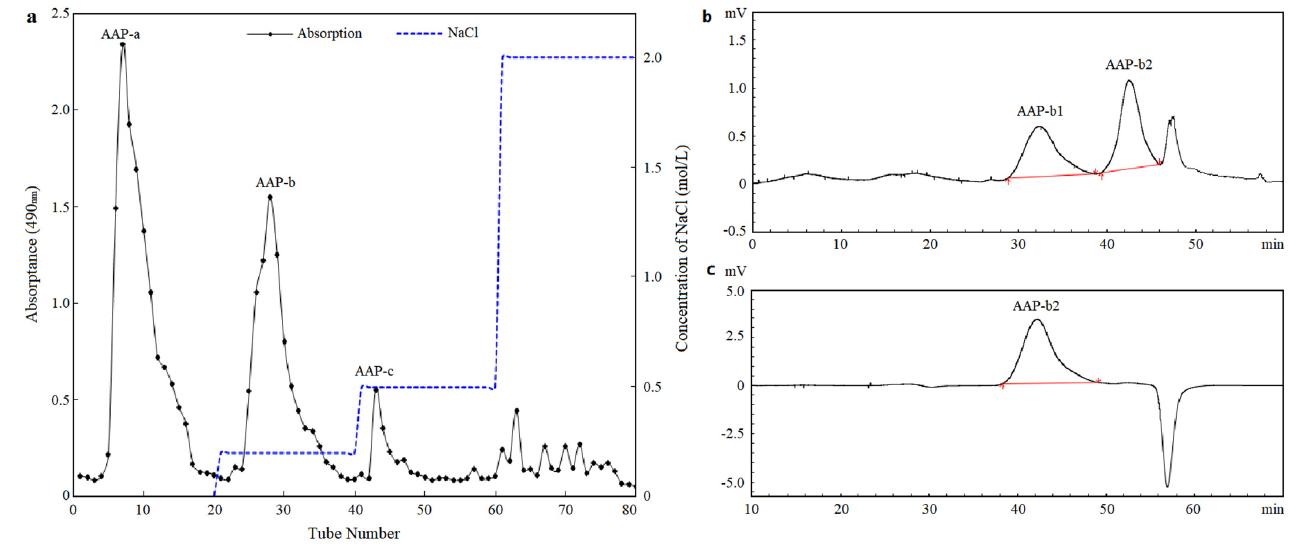
Figure 1. Isolation and purification of polysaccharides extracted from A. auricula . ( a ) Elution curve of AAP on DEAE Sepharose Fast Flow column. ( b ) HPGPC profile of AAP-b. ( c ) HPGPC profile of AAP-b2.